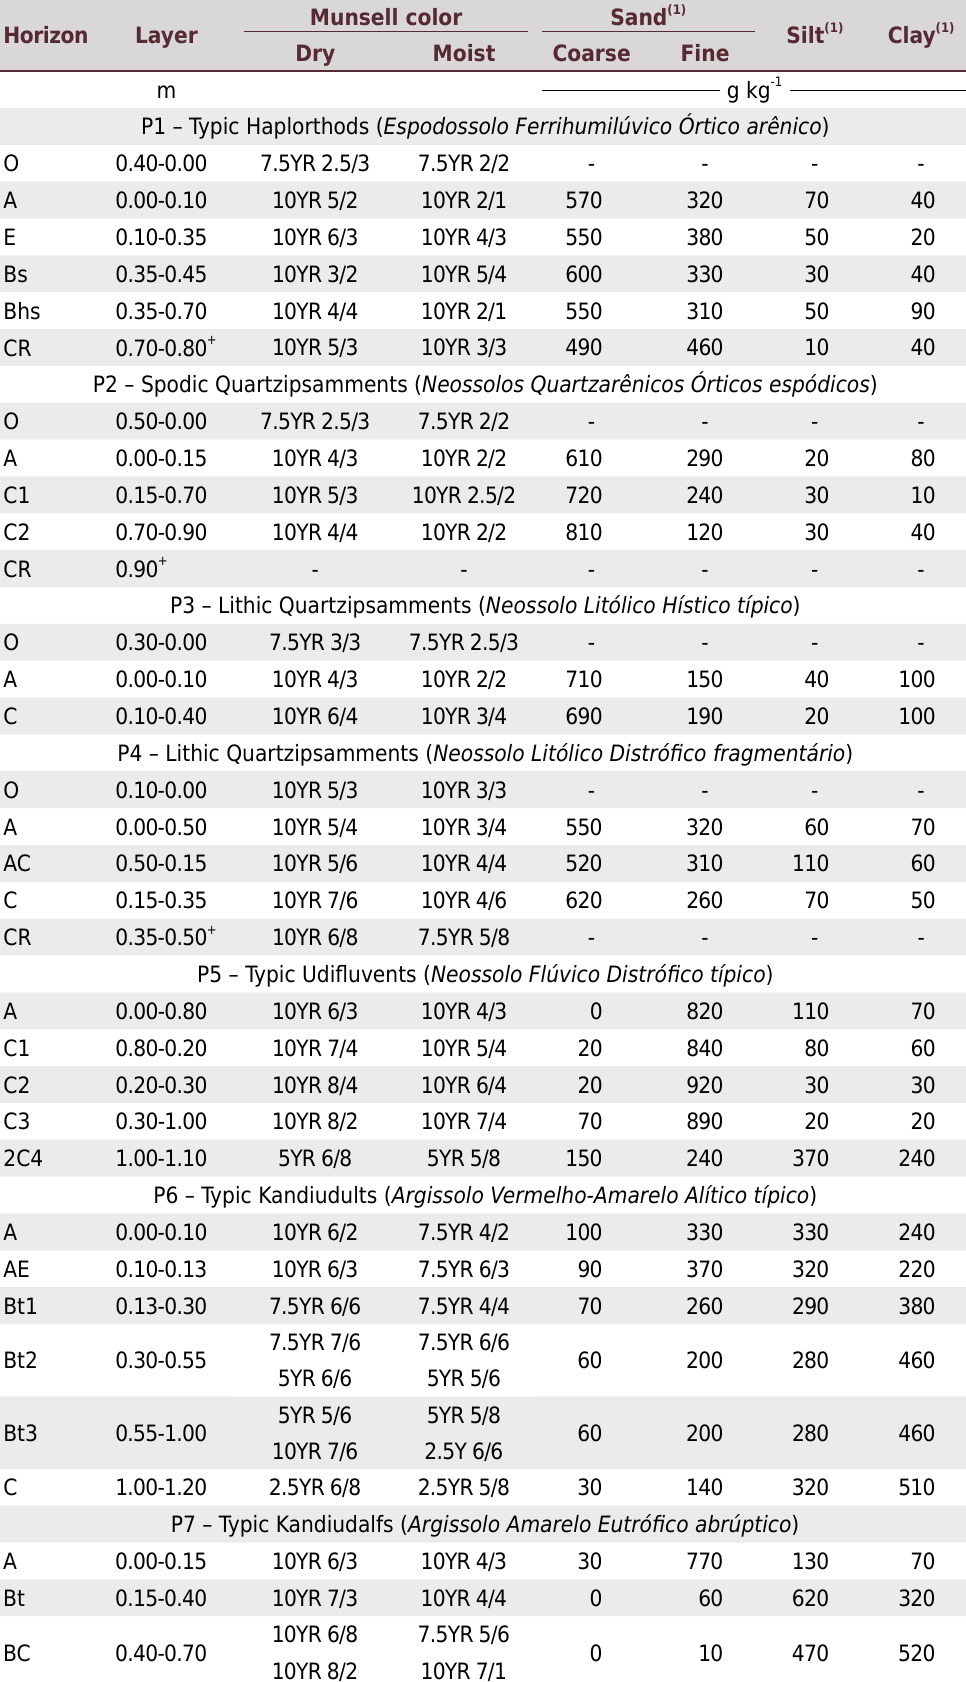
Table 3. Physical properties of the <2 mm fraction of the studied soils